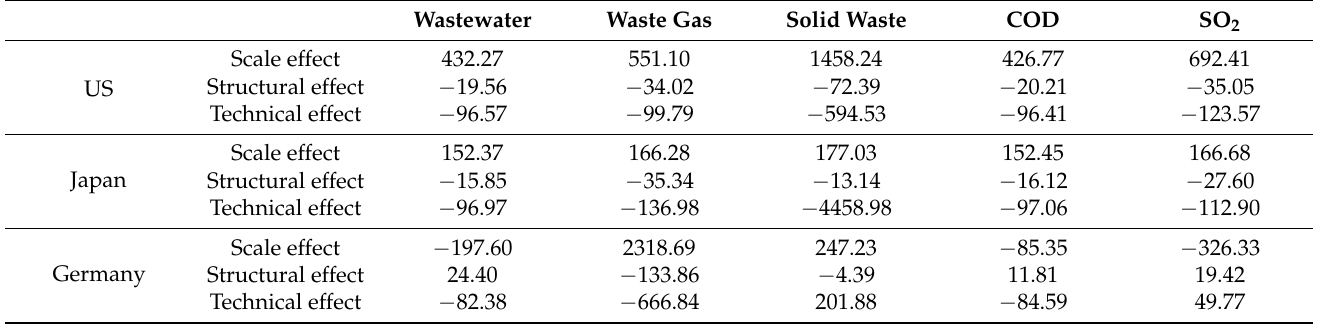
Table 2. The effect decomposition of revised BEET (unit: %).